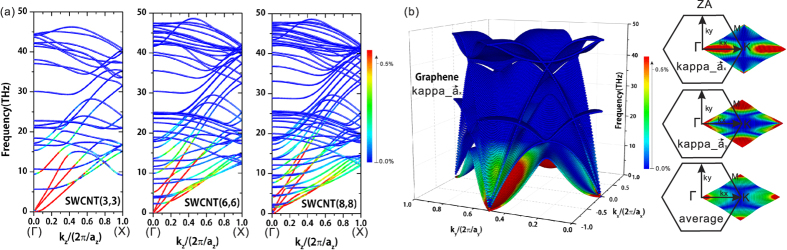
(a) shows the thermal conductivity contribution (in percentage) from each phonon mode of SWCNT(3,3), SWCNT(6,6), and SWCNT(8,8); (b) presents thermal conductivity contribution (in percentage) along lattice vector  from each phonon mode of graphene in whole BZ (3D-space phonon dispersion) and phonon thermal conductivities from ZA modes (2D-projection BZ, along lattice vector , , and average value of both directions).